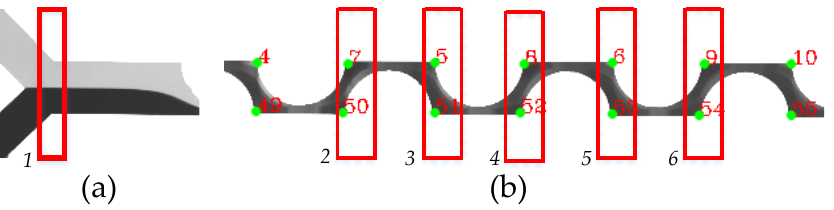
Figure 5. Cross-sections to calculate the efficiency: ( a ) reference section (r1); ( b ) sections that are selected for the efficiency calculation.